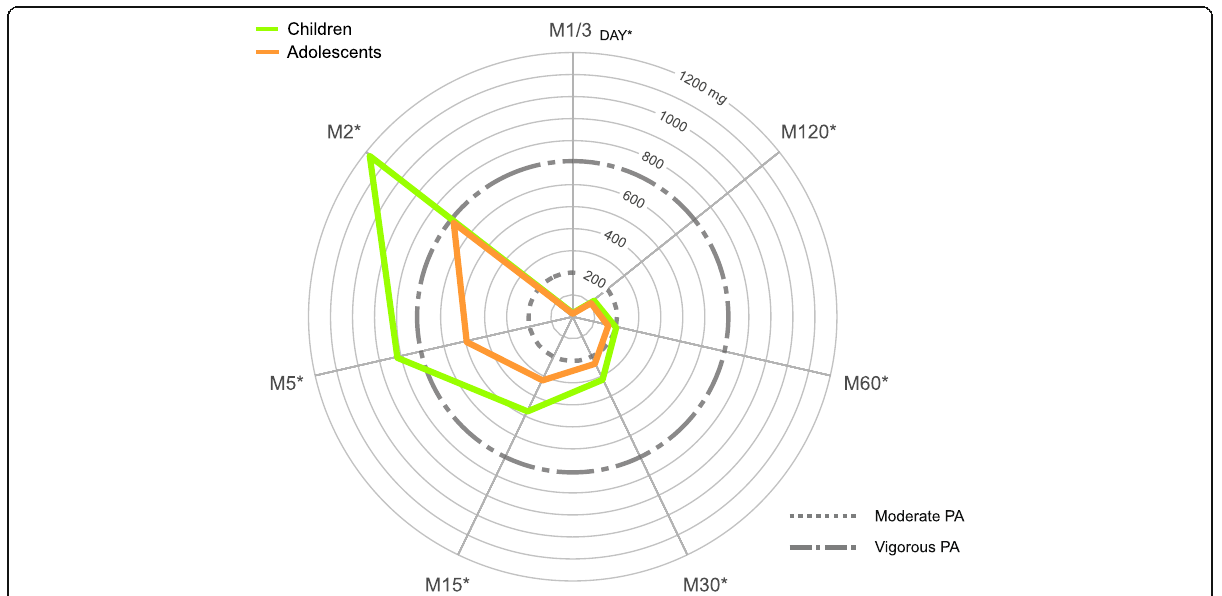
Fig. 1 Radar plots illustrating differences in MX metrics between children and adolescents. MX metrics representing the acceleration (m g ) above which the most active 2 min (M2), 5 min (M5), 15 min (M15), 30 min (M30), 60 min (M60), 120 min (M120), and 8 h (M1/3 DAY ) of the day are accumulated; PA, physical activity; * p < 0.05